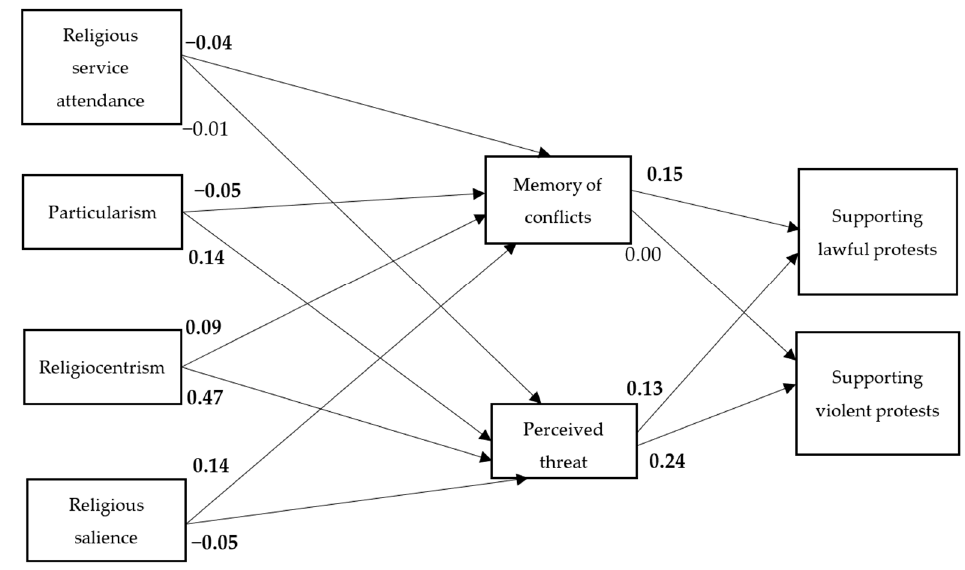
Figure 2. SEM analysis on the hypothesized